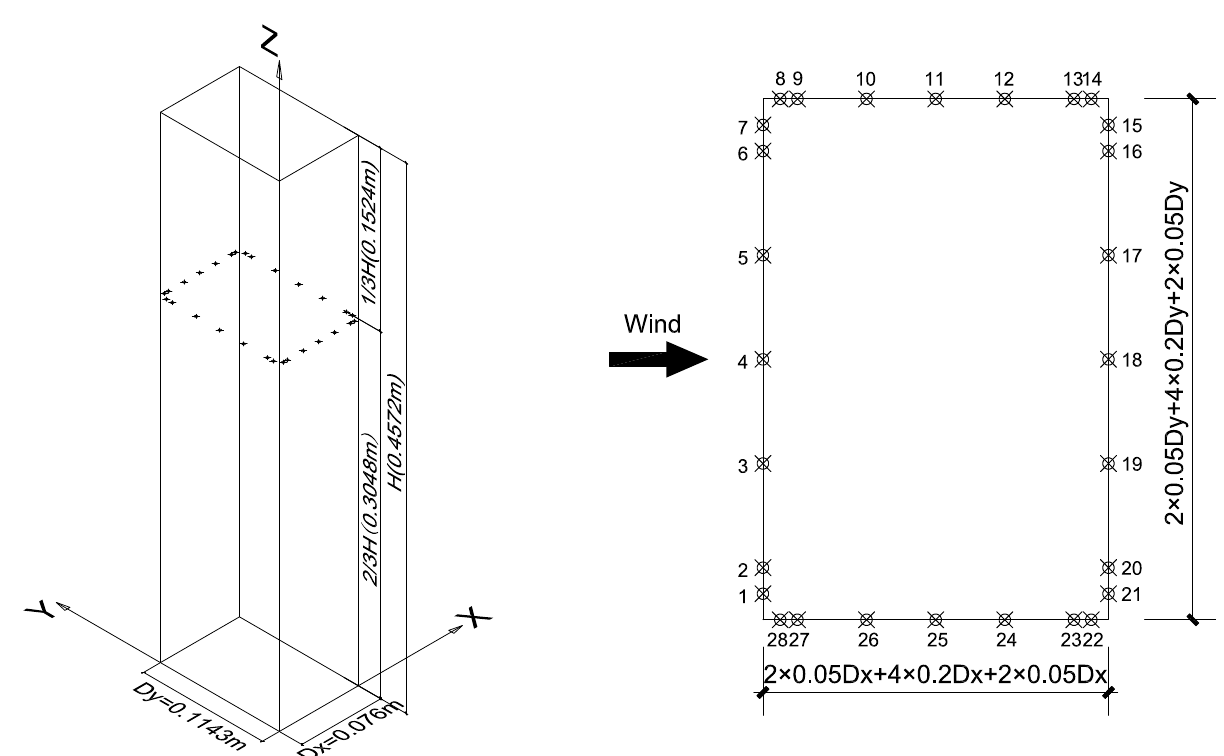
Figure 14. Arrangement of measuring points at 2/3 H of the CAARC model.